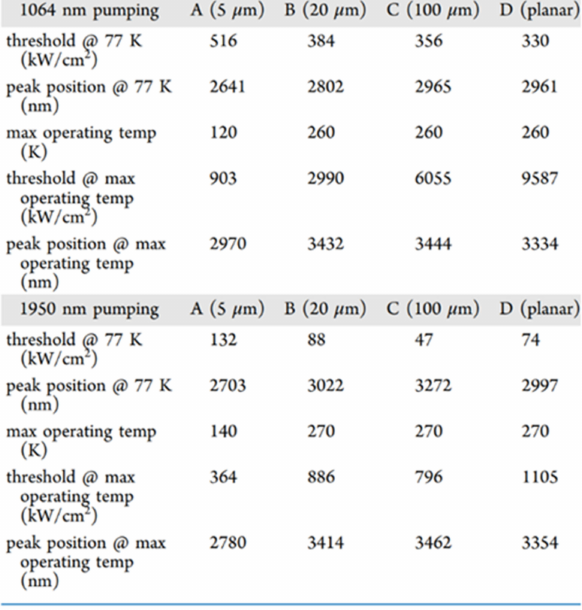
Figure 27. Summary of laser performance under 1064 and 1950 nm pulsed laser injection (the cavity widths for samples A, B, C, and D were 5 µ m, 20 µ m, 100 µ m, and planar, respectively). Reproduced with permission from [76], ACS Publishing,